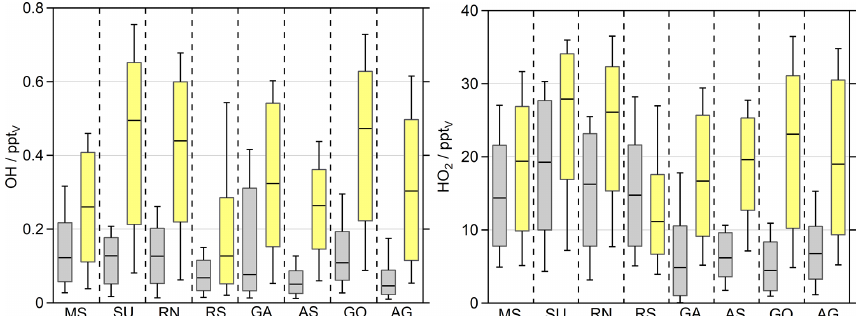
≥ 10 − 3 s − 1 ) of the observations (grey) and the EMAC simulations (yellow). The box repre- Figure 5. OH and HO 2 daytime values ( j NO 2 sents 25% to 75% of the data, and the whiskers are from 10% to 90% with the median as the black line. The EMAC data were adapted to the measurements with a time resolution of 10min so that the diurnal variations are reflected